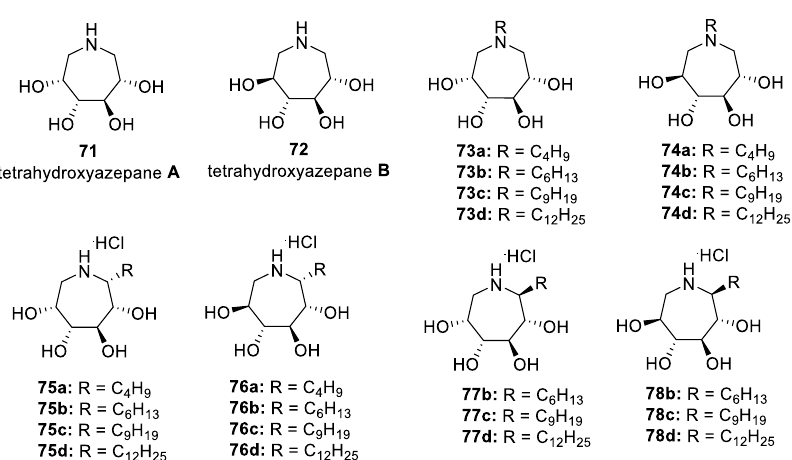
Figure 15. Tetrahydroxylated azepanes evaluated by Désiré and co-workers [156]. Int. J. Mol. Sci. 2020 , 21 , x FOR PEER REVIEW 17 of 35